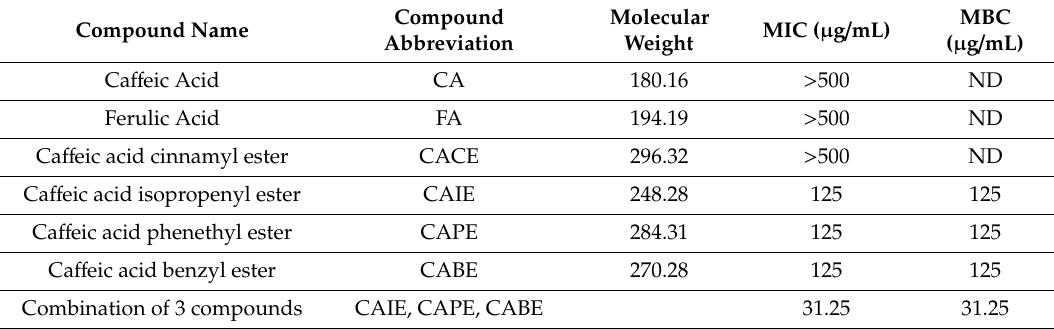
Table 1. Minimum Inhibitory Concentration (MIC) and Minimum Bactericidal Concentration (MBC) for individual caffeic acid esters or for a combination treatment against P. larvae.